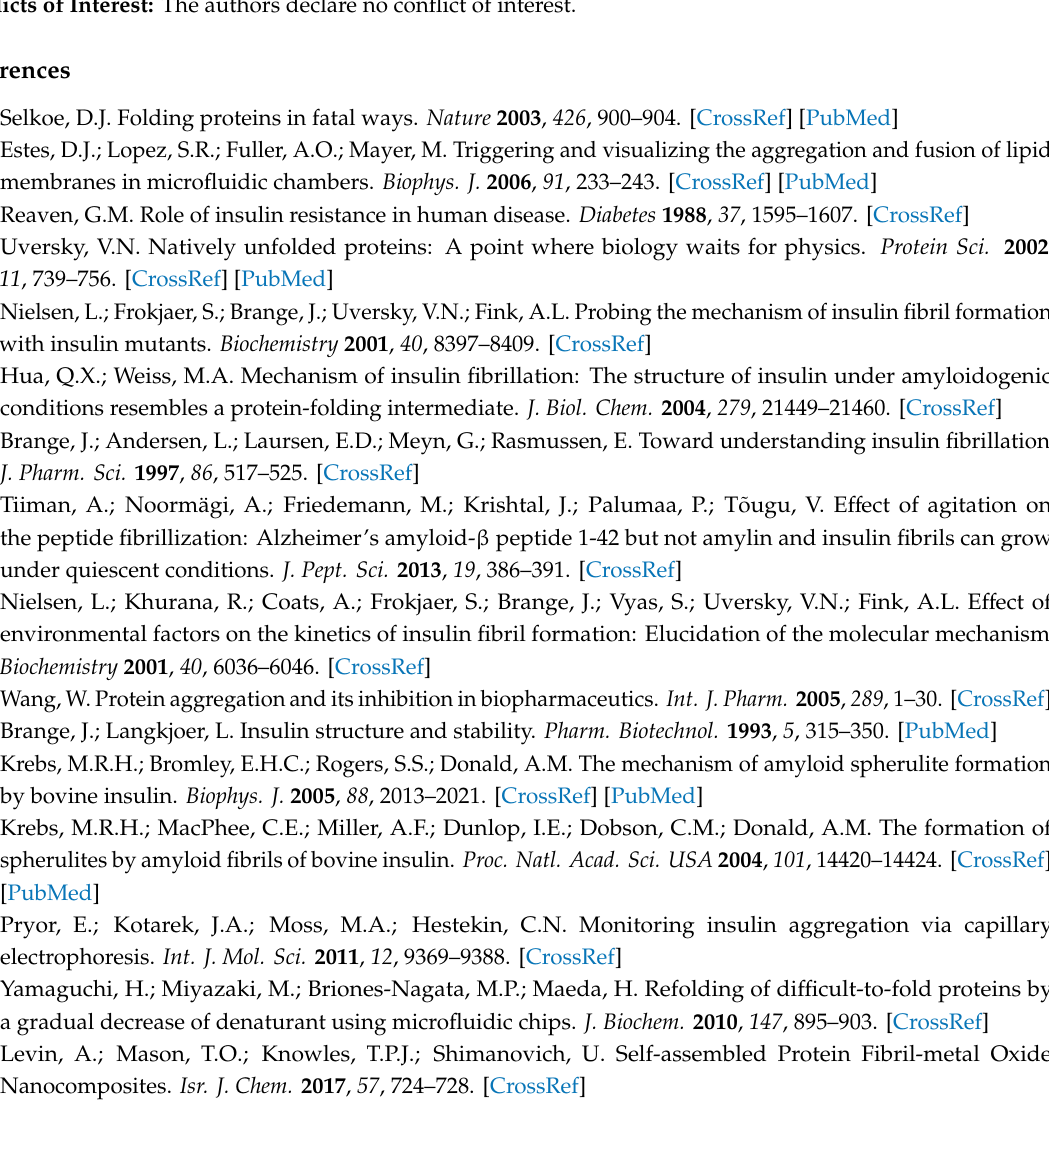
applied pressures. Figure S2: Mixing e ffi ciency test. Protocol S1: Fabrication process of microfluidic devices. Figure S3: Temperature control setup. Equation S1: Kinetics of insulin fibril formation. Figure S4: Microfluidic device design for the optimization of operations. Movie S1: Device operation. Movie S2: Mixing valve operation, and COMSOL model file—the simulation of mixing valve